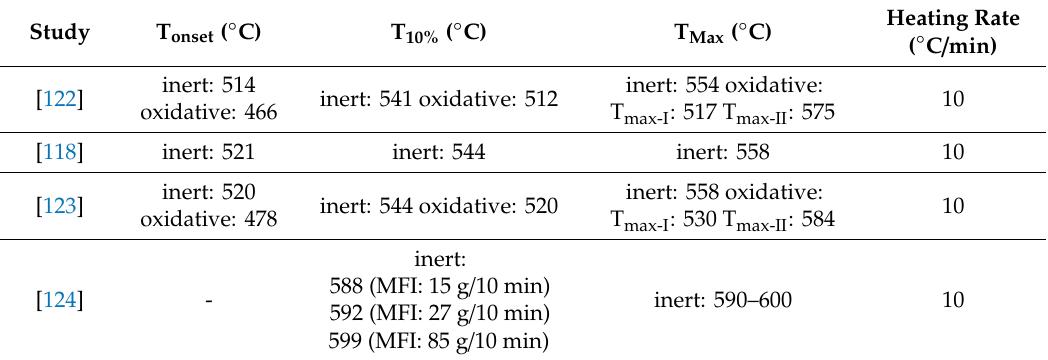
Table 6. Summary of the thermal degradation parameters (obtained from TGA test) for PEEK.